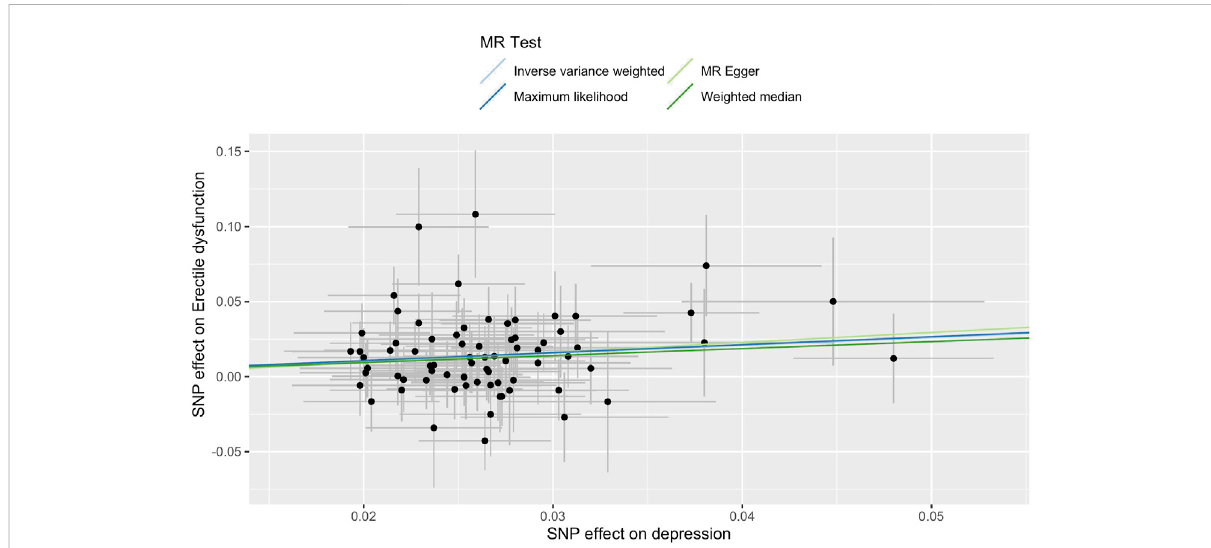
FIGURE 3 Scatter plot of the effect size of each SNP on depression and ED in MR. Abbreviations: SNP, single-nucleotide polymorphism; ED, erectile dysfunction; MR, Mendelian randomization.